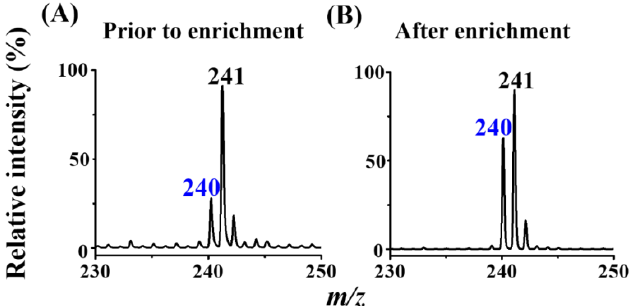
Figure 3. C-API mass spectrum of the sample containing ( A ) E. coli O157:H7 with the concentration of OD 600 of ~10 − 6 , obtained after endogenous peroxidase reactions. ( B ) C-API mass spectrum of the sample, obtained by using the MALCY-probe to trap the sample (3 mL) containing E. coli O157:H7 with the concentration of OD 600 of ~10 − 6 , followed by releasing the bacterial to ammonium acetate buffer (pH 4.5) and conducting endogenous peroxidase reactions. The endogenous peroxidase reaction samples in Panels A and B were 100-fold diluted with ethanol/deionized water (2:1, v / v ) prior to C-API-MS analysis. One droplet of the resultant sample (5 µL) was used for C-API-MS analysis.